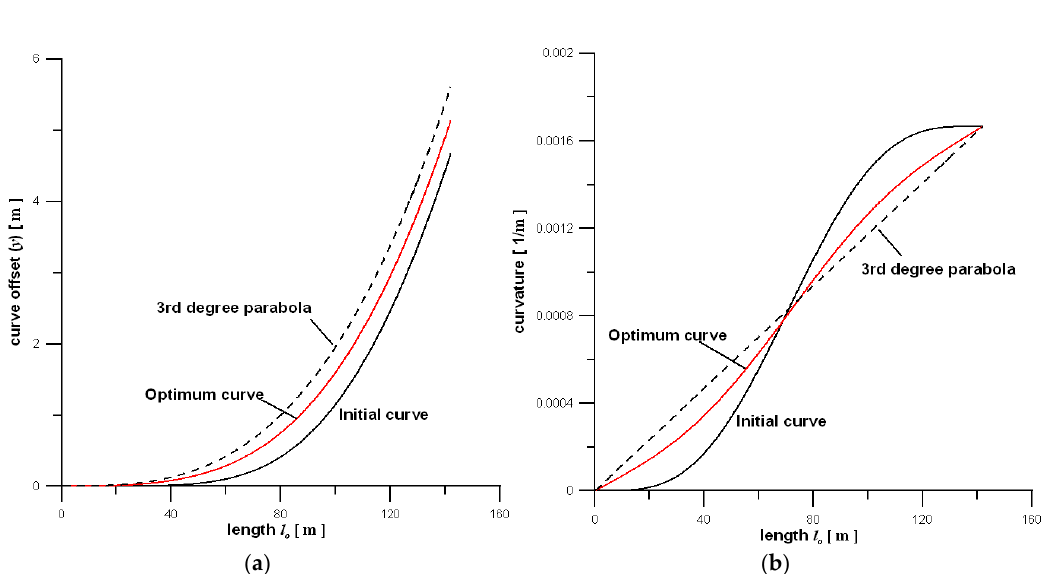
Figure 6. Transitions curves: ( a ) Curve offsets; ( b ) curvatures. Figure 7 shows the comparison of the lateral displacement and acceleration of the center of mass of the car body for the initial curve, the optimum curve, and also the 3rd degree parabola. Both the displacement graph (Figure 7a) and the acceleration graph (Figure 7b) clearly show that the optimum curve is better than both the standard curve, and the 3rd degree parabola. No tably, in this context, interesting is Figure 7b for accelerations. ( a ) ( b ) Figure 7. Dynamical characteristics; ( a ) Vehicle body lateral displacements; ( b ) vehicle body lateral accelerations. The ratio of the objective function values (the optimum curve/3rd degree parabola) is 0.59 = (0.0018622 [m/s 2 ]/0.0031123 [m/s 2 ]). The ratio of the optimum objective function value to that one for the 9th degree standard curve is 0.35 = (0.0018622 [m/s 2 ]/0.0051947 [m/s 2 ]). Figure 8 presents the comparison of other graphical results — here, the lateral accel- eration of the car body around the x -axis for the initial (standard) curve of 9th degree